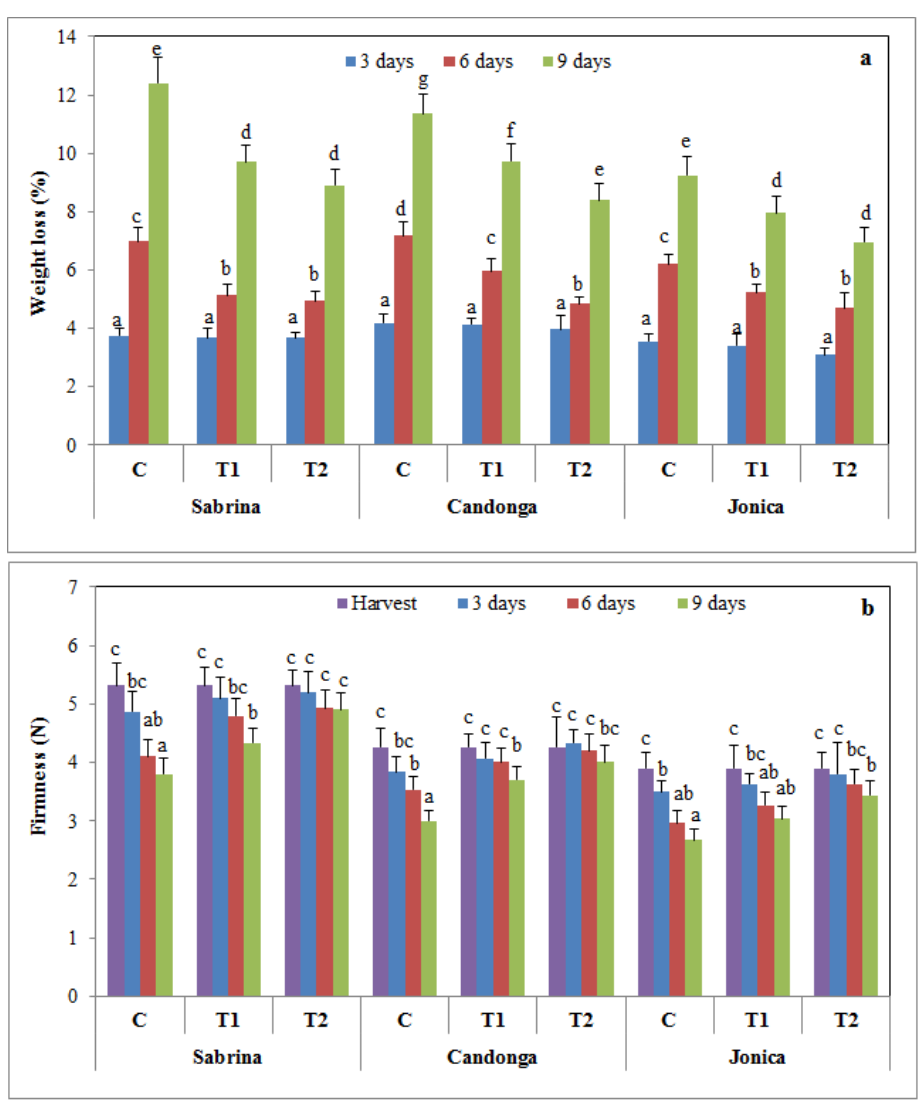
Figure 1. Changes in weight loss ( a ) and firmness ( b ) of strawberry cultivars during cold storage at 2 °C for nine days (C, control; T1, 1% chitosan coating; T2, 2% chitosan coating; error bars indicate the standard